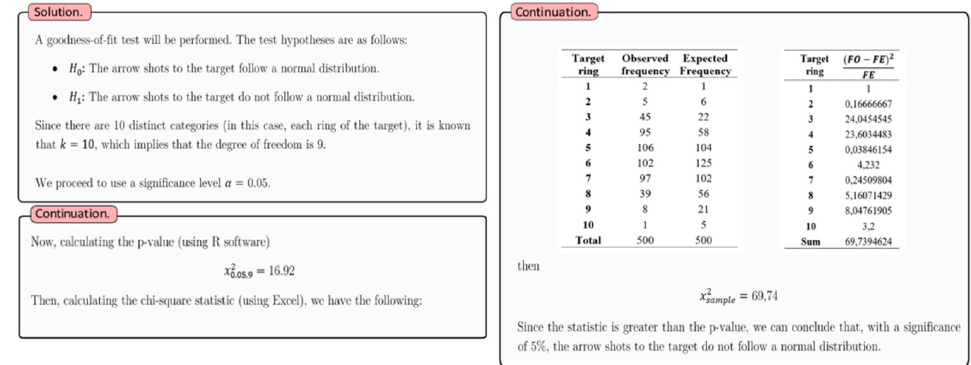
Figure 5. The practice of prospective Teacher 11 (G2) on Activity 1.